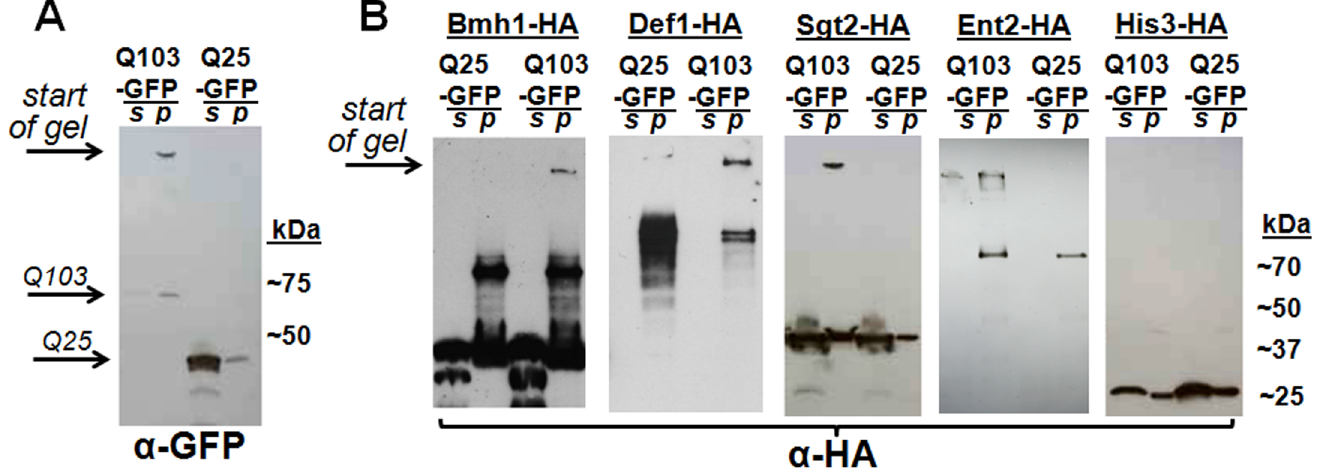
Fig 3. Western blotting confirms that TAPI-identified proteins are trapped in large, detergent-resistant Htt-polyQ aggregates. (A) Immunoblotting reveals that Htt-Q103-GFP, but not Htt-Q25-GFP, forms large detergent-resistant aggregates that fractionate in the pellet (partial TAPI purification; see methods) and remain at the top of an acrylamide gel under SDS-PAGE conditions. (B) Immunoblotting confirms that HA-tagged Bmh1p, Def1p, Ent2p, and Sgt2p (proteins identified by mass spec) get trapped in the detergent-resistant aggregates that can be seen stuck at the top of the gels in the pellet fractions. As a negative control, HA-tagged His3p (not identified by mass spec) shows no susceptibility to co-aggregation with Htt-Q103-GFP. Note that Def1p was not easily visualized in the supernatant fraction because it is prone to degradation (data not shown). Samples were spun at 45,000 rpm, except Ent2p (10,000 rpm). S = supernatant; P = pellet